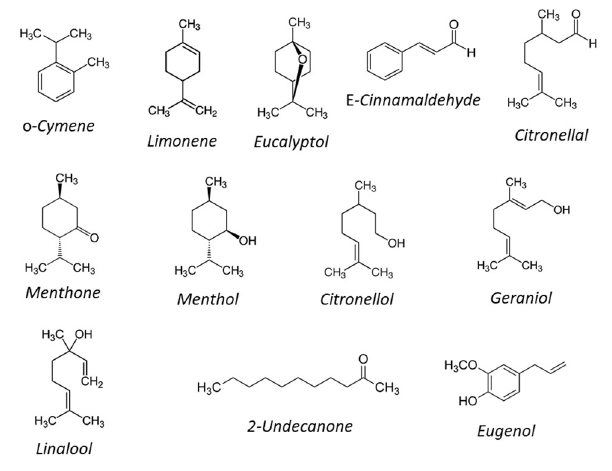
Figure 1. Chemical structure of main constituents of the ten EOs.